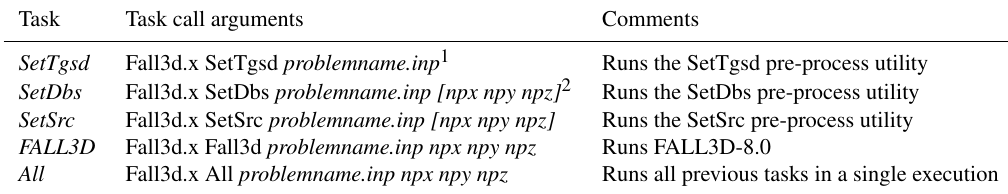
Table 11. Summary of the FALL3D-8.0 model